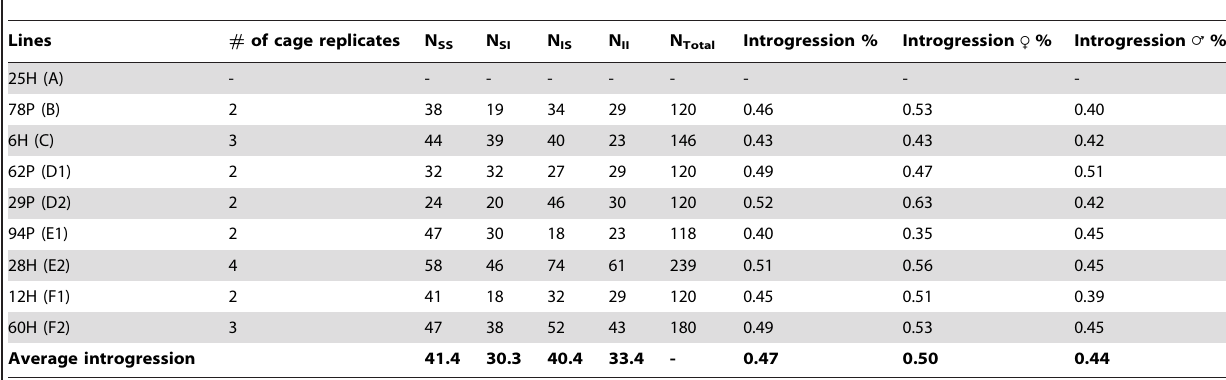
Table 3. Mating success tests between each introgression line and the simulans strain.